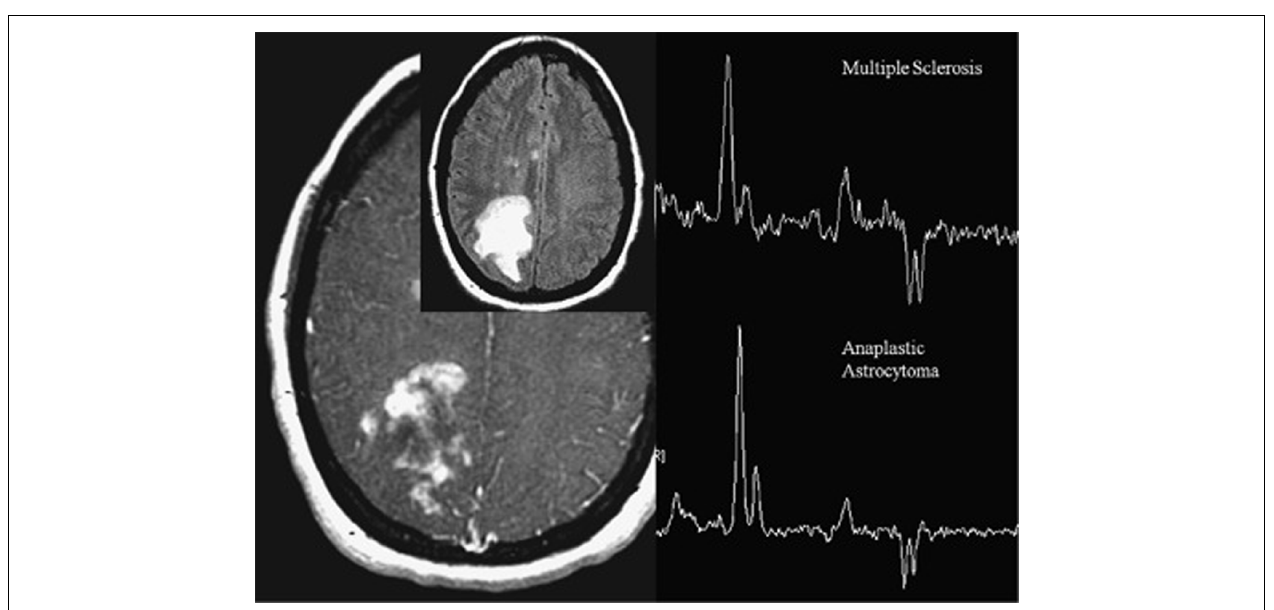
anaplastic astrocytoma. In anaplastic astrocytoma, choline elevation reflects membrane synthesis as marker of active proliferation, whereas in MS, it represents membrane injury and degradation of membrane phospholipids. Adapted fromYoung (2007) reproduced with